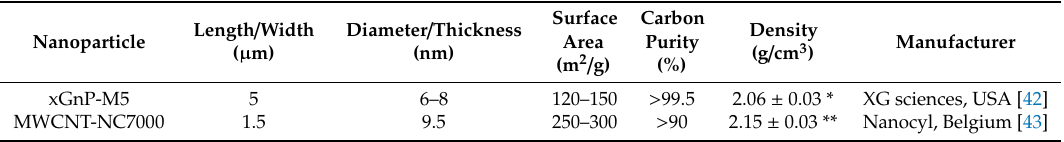
Table 1. Properties of commercial grades of graphene nanoplatelets (GNPs) and multi-walled carbon nanotubes (CNTs) according to the